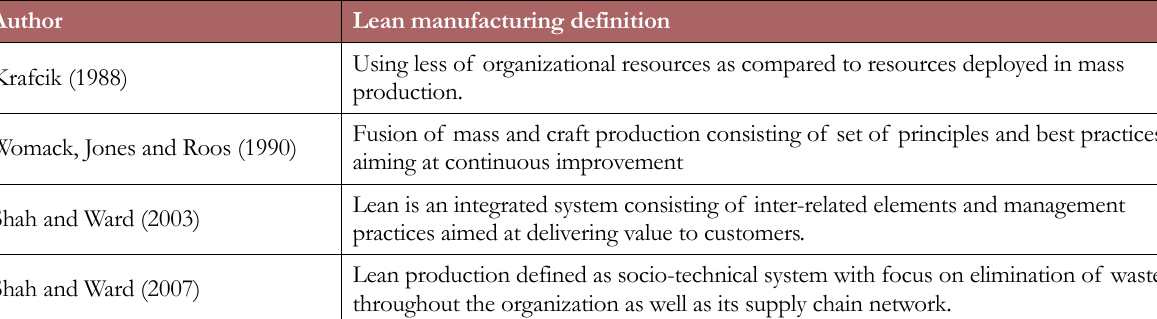
Table 1. Lean Manufacturing Definitions: Key